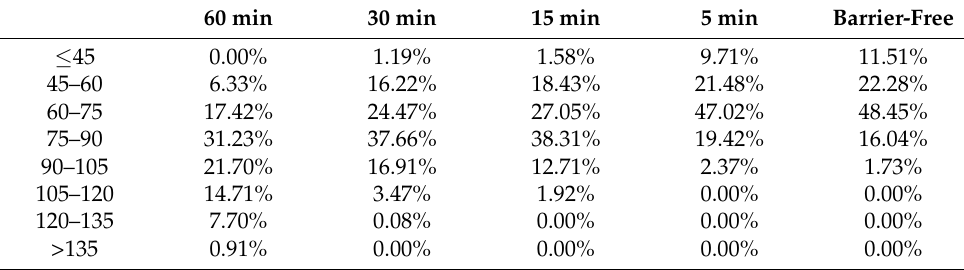
Table 6. Percentage of accessible